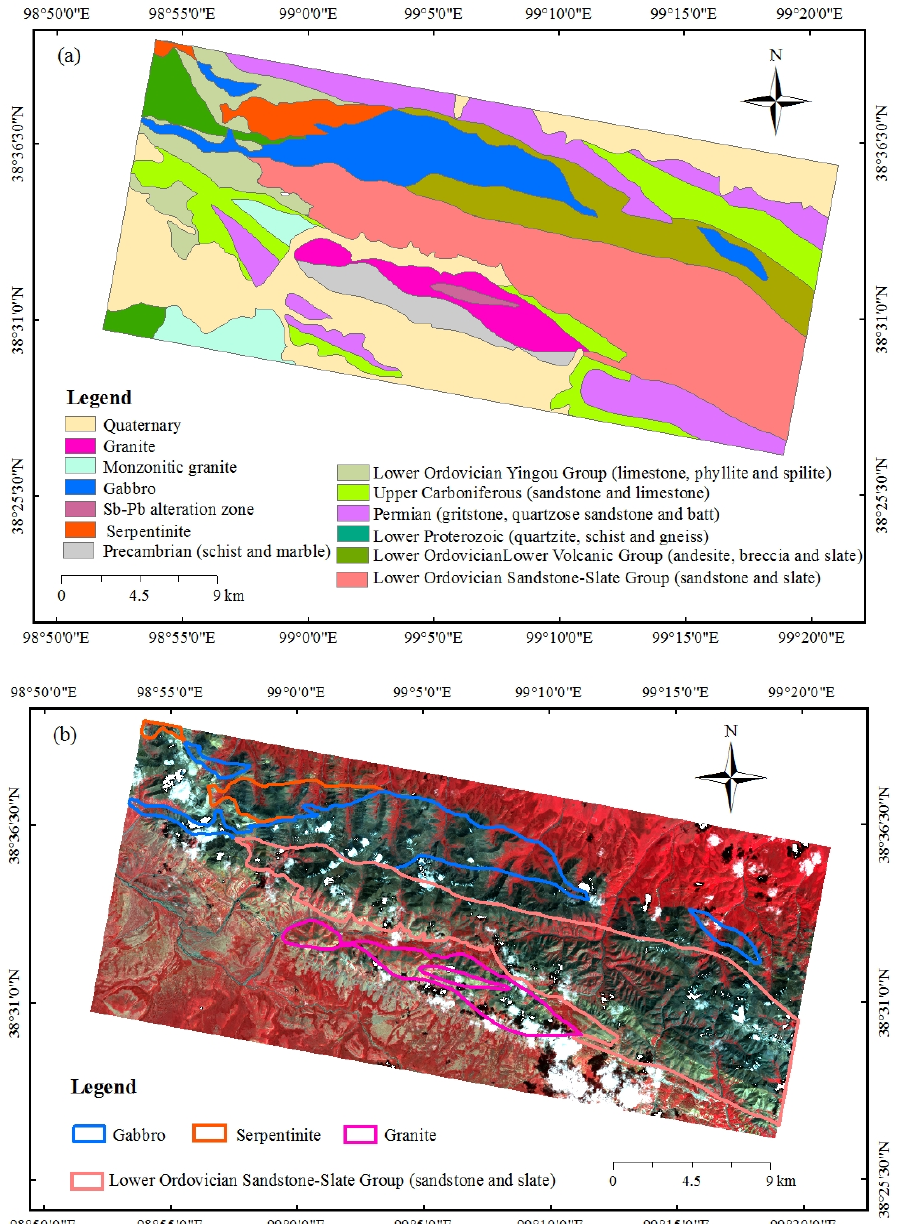
Figure 2. ( a ) Generalized lithological map of the study area, showing the major lithology boundaries, modified after Ding et al. [49], Copyright 2014, Elsevier; and ( b ) false color composition with R = band 5 (near-infrared ( NIR ), 0.845–0.885), G = band 4 (Red, 0.630–0.680), and B = band 3 (Green, 0.525–0.600) in the study area with the lithological boundaries of gabbro, serpentinite, granite and Lower Ordovician Sandstone–Slate Group derived from Figure 2 ( a ) to highlight the distribution of the discussed rock types in this